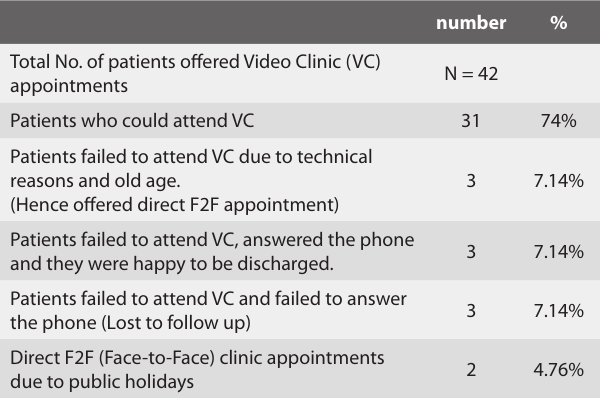
Table 1. An analysis of patients offered appointment in video clinic and their actual attendance.